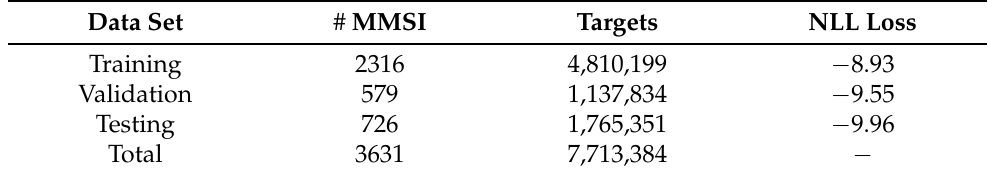
Table 3. NLL loss for Training, Validation and Testing. The Training NLL is the highest due to a high regularisation during training, but not so during inference. For each sample, a single target with f features is given.